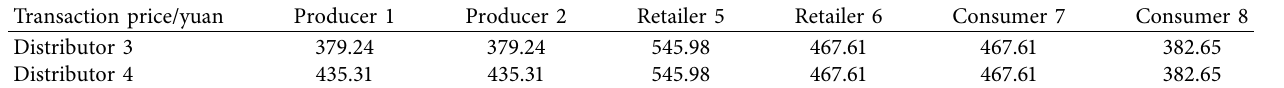
Table 8: Transaction prices of green products in the GSCDN under government